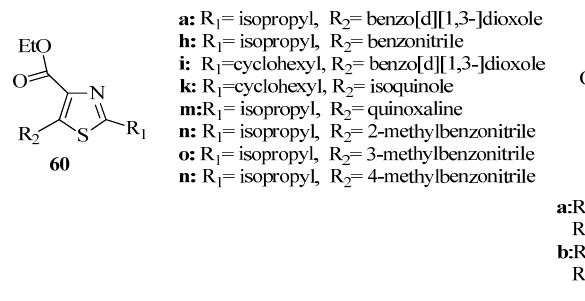
Figure 23. Structures of 2,4,5-trisubstituted thiazoles.